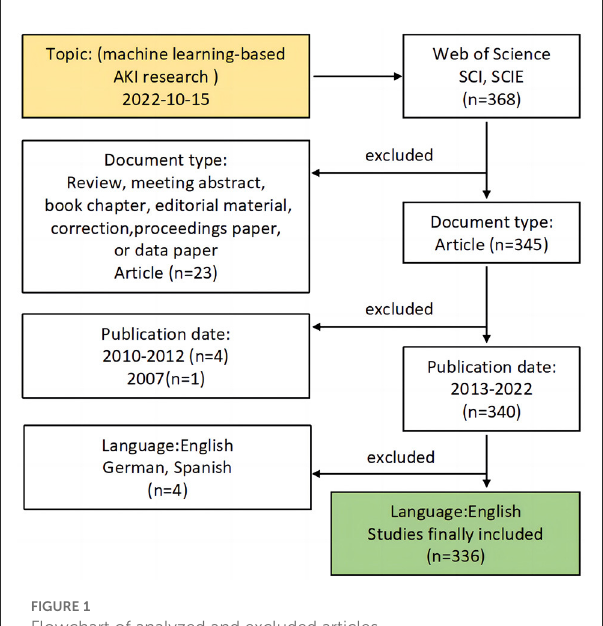
FIGURE1 Flowchart of analyzed and excluded